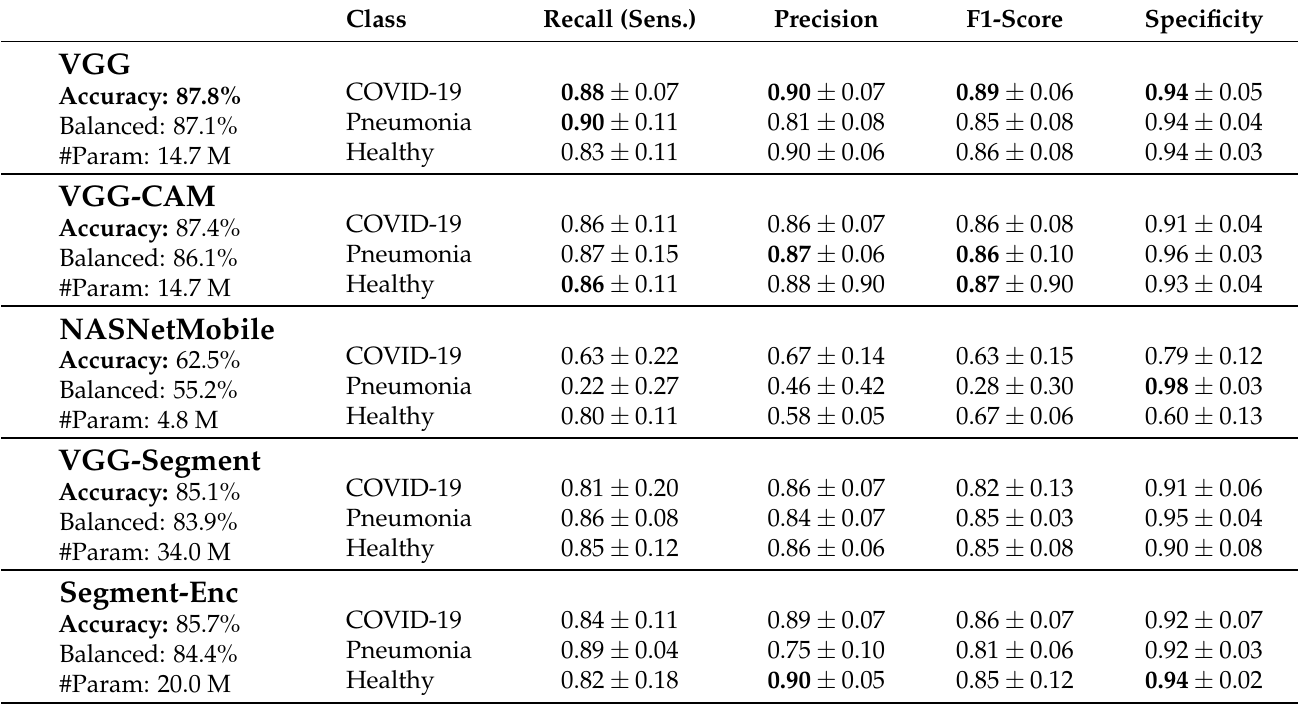
Table 2. Comparison of the tested classification models on 5-fold cross validation for each class. Accuracy abbreviates accuracy, Bal. balanced accuracy, Coefficient and Par. the number of parameters (in millions). For each class and each column the best model is highlighted in bold. The accuracy of 88% of VGG and VGG-CAM cannot be outperformed by pre-trained lung US segmentation models from [57], and unfortunately it cannot be matched by NASNetMobile , a model that is significantly smaller. Class Recall (Sens.) Precision F1-Score